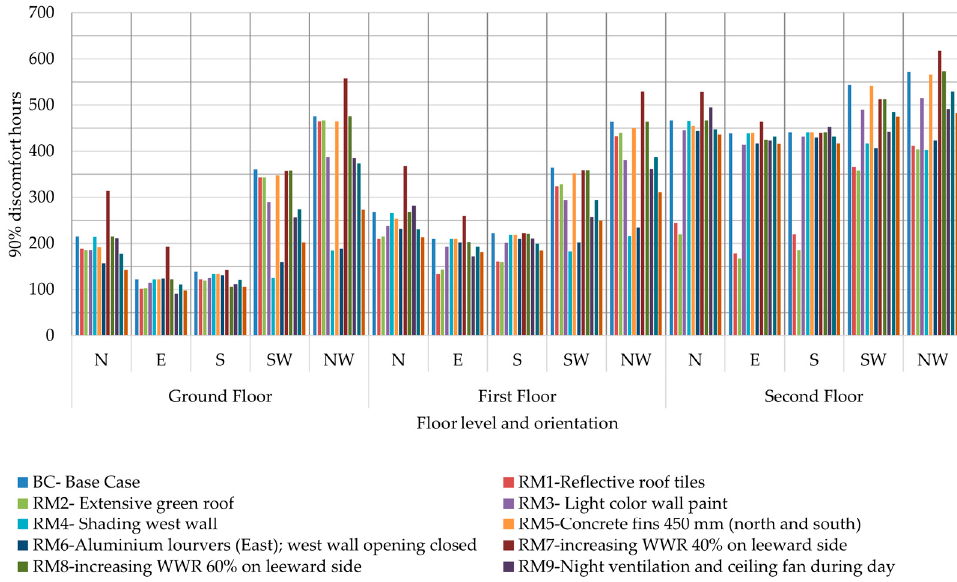
Figure 6. Impact of various envelope retrofit strategies.